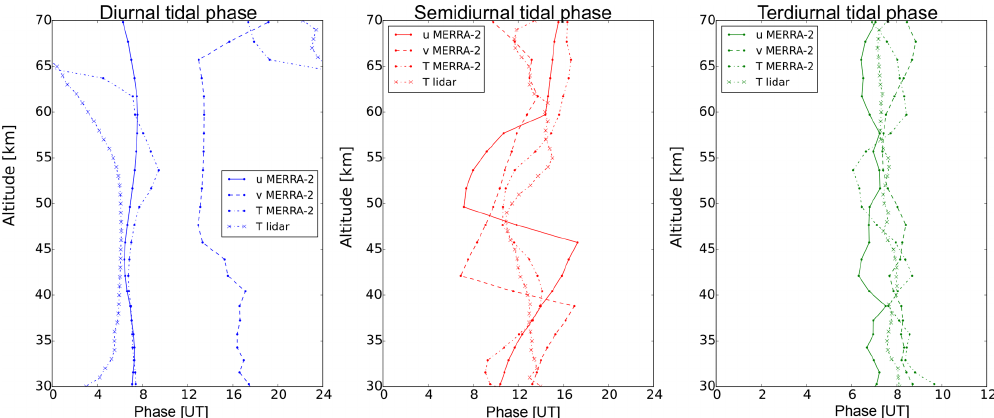
Figure 6. The diurnal (blue), the semidiurnal (red) and the terdiurnal (green) tidal phases derived from the lidar temperature field (dotted line with crosses), from the MERRA-2 zonal (solid line) and from the meridional wind field (dashed line) as mean over all days of the sounding period in May 2016. Please note the different x scale for the terdiurnal tidal phase. For comparison the tidal phases from the temperature field of MERRA-2 are also shown (dotted line with